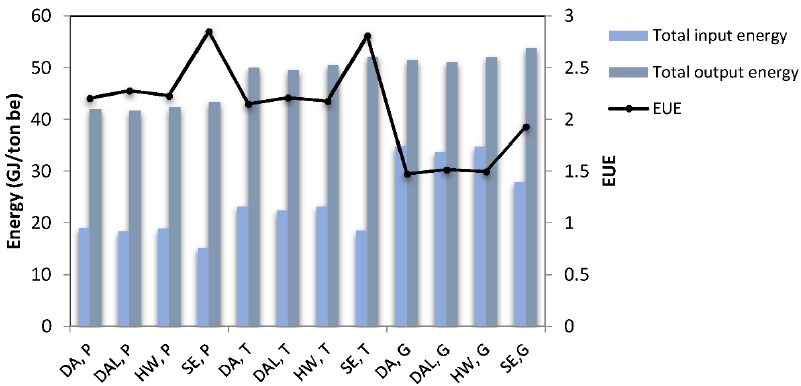
Figure 5. Total input energy, total output energy and EUE for 1 ton bioethanol production from different wastes.